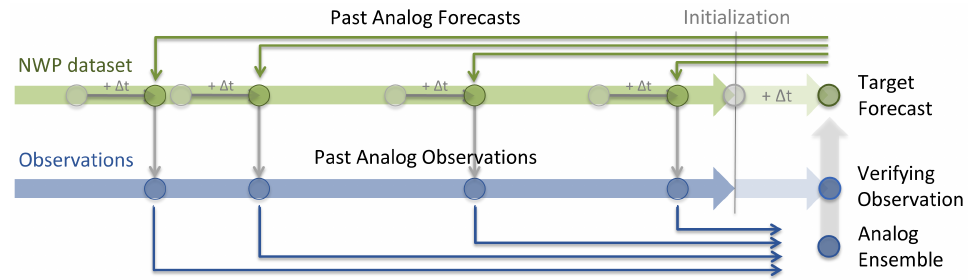
Figure 2. Illustration of the analog ensemble (AnEn)